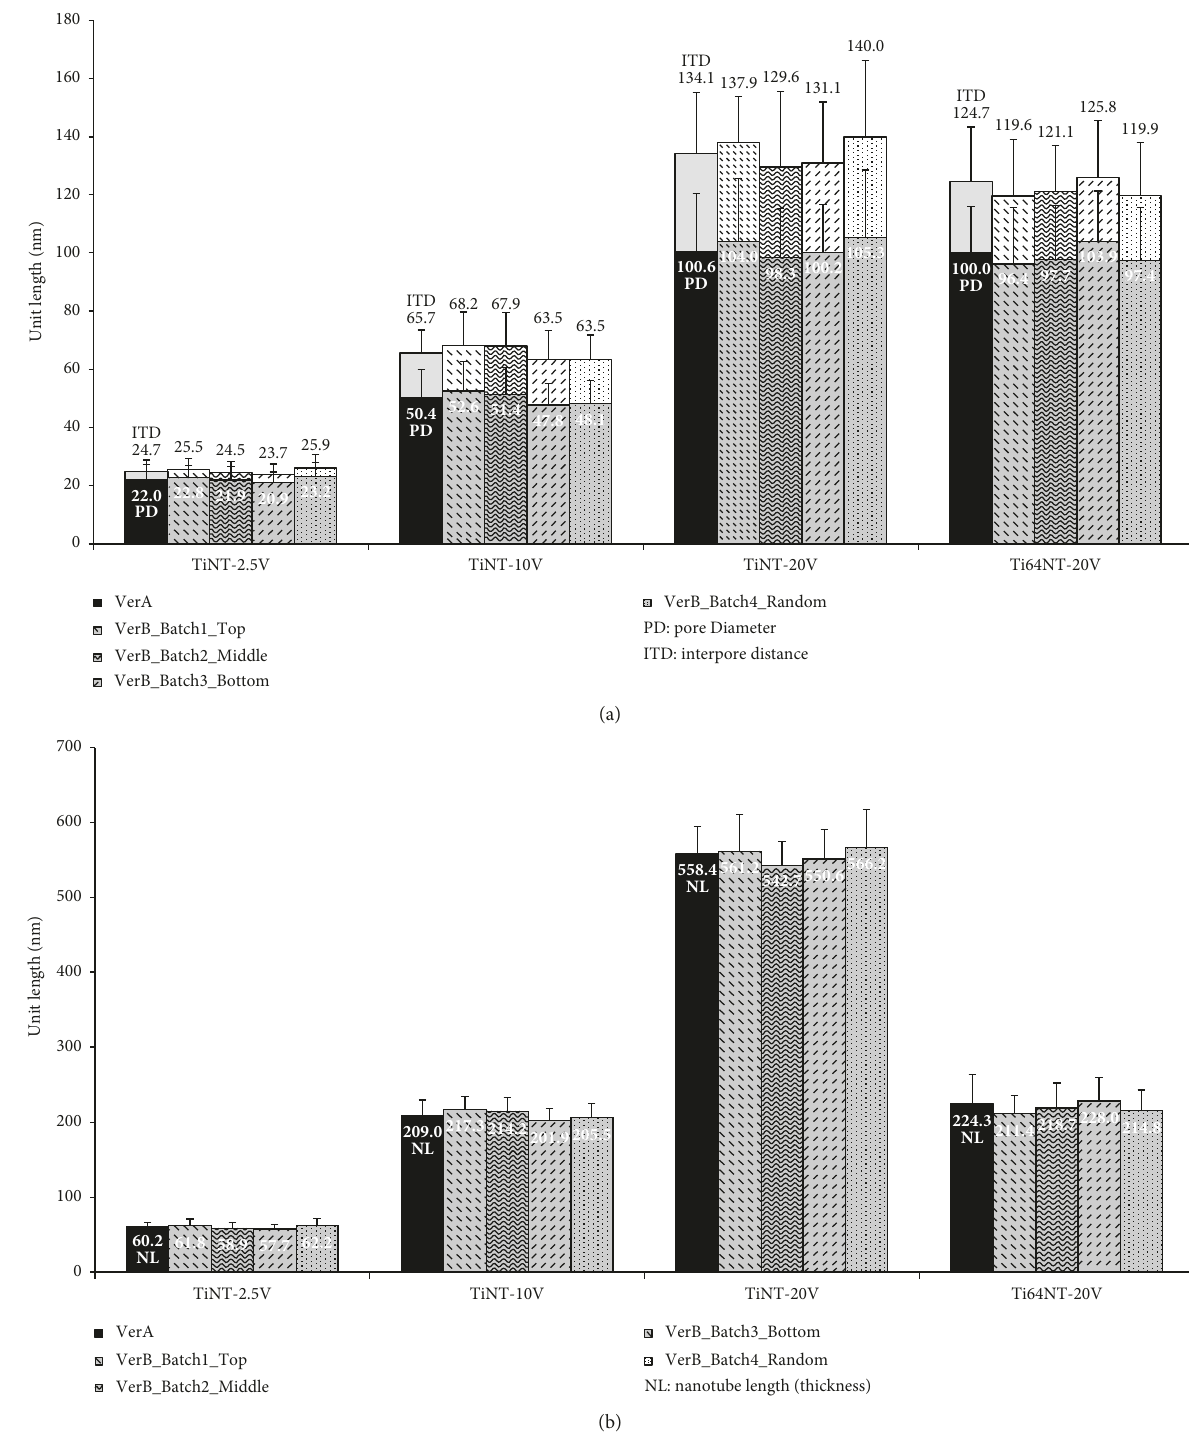
Figure 6: Statistical plots of the nanotube dimensions correspond to their respective anodising potentials; (a) the pore diameter (lower bar, labelled PD) and the interpore distance (upper bar, labelled ITD) of the anodised specimen using Version A (first bar with solid black fill) and one specimen from each of the four batches using Version B (bars with patterned fill), chosen from different positions in the 10- specimen holder, i.e., top corner, middle, bottom corner, and random position, as indicated in Figure 3. (a) n standard deviation; (b) the nanotube length of the anodised specimens, measured using the same specimen as (a) ( n represent standard